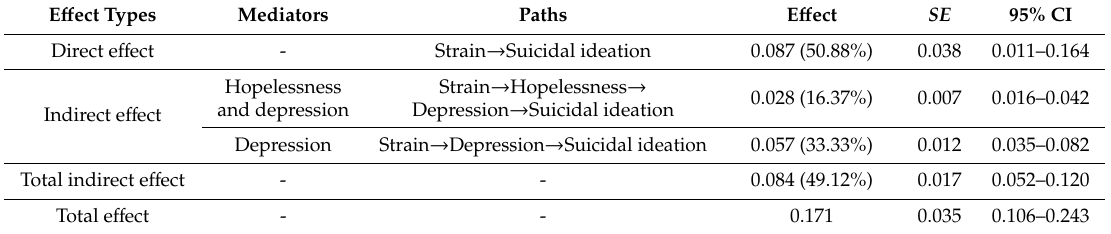
e ff ects are illustrated in Table 5. The direct e ff ect of psychological strain on suicidal ideation was significant (95% CI: 0.011–0.164), and the total indirect e ff ect was also significant (95% CI: 0.052–0.120). The indirect e ff ects of psychological strain on suicidal ideation via the mediation of depression (95% CI: 0.035–0.082) and hopelessness and depression (95% CI: 0.016–0.042) were both significant. Table 5. Direct and indirect e ff ects of psychological strain on suicidal ideation in